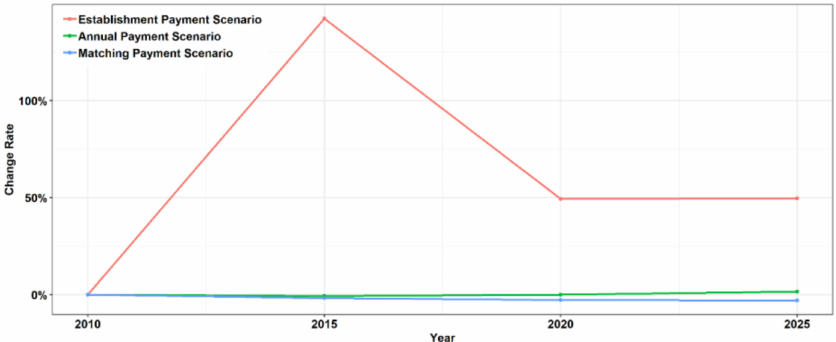
Figure 4. Production change of industrial